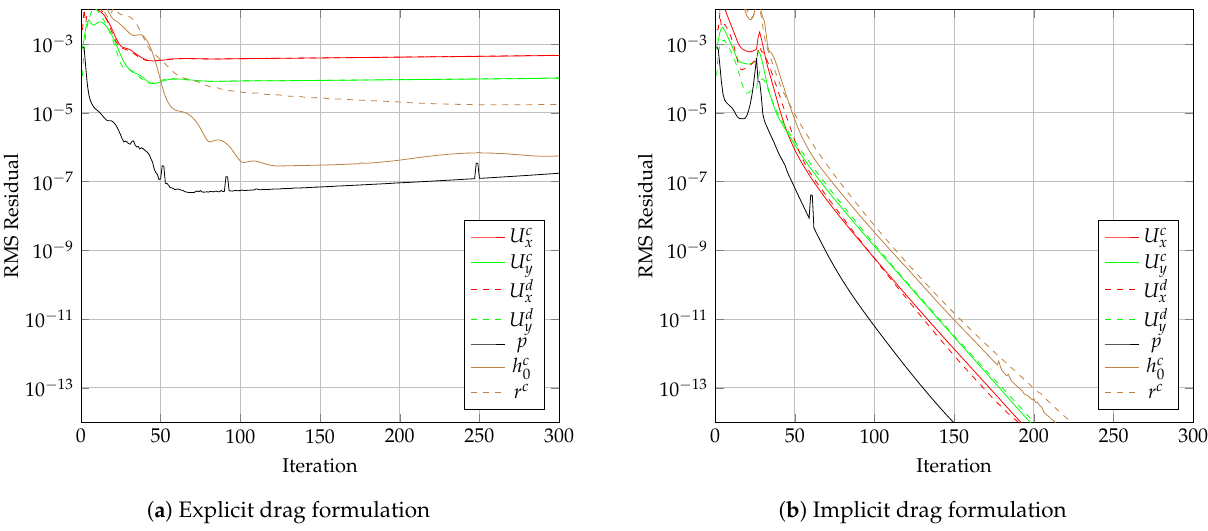
Figure 8. Root mean square (RMS) residual error for r d = 1 µ m with different numerical frameworks. The coupled framework was introduced in Section 4. A method is proposed that solves the two sets of momentum equations and the continuity equation in a 7 matrix structure. It was later explained in Section 5.1 how this framework allows to treat inter phase drag implicitly in the coefficient matrix. The coupled drag formulation is therefore compared to traditional semi-implicit, segregated treatment of the drag term. In order to to so, the coefficients marked in blue in Equation (13) are entirely moved to the right hand side of the linearized equation system. The comparison therefore only differs in the treatment of the drag term, any other coupling is kept and the setup of the test case is identical. The results shown in Figure 9 clearly demonstrate the advantages of the proposed solutions. The RMS-residuals of the implicit formulation shown in the figure to the right outperform the explicit formulation.